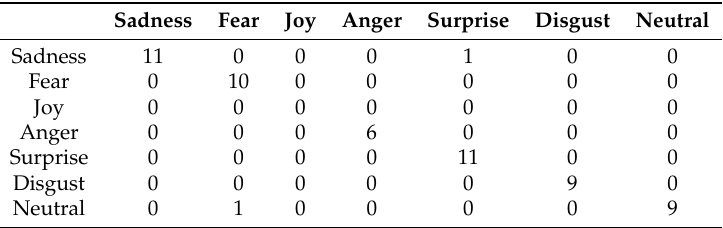
Table A19. A2 actor confusion matrix from the Emo-DB in the third